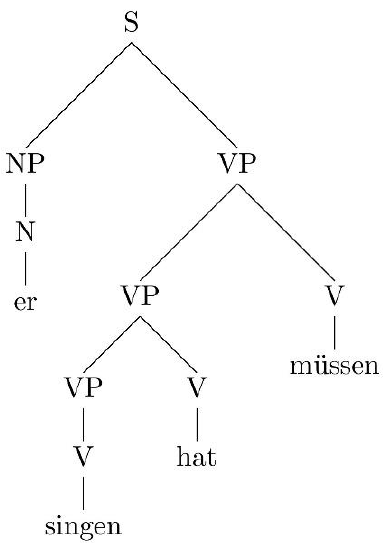
Figure 14. Derived tree after adjunction .